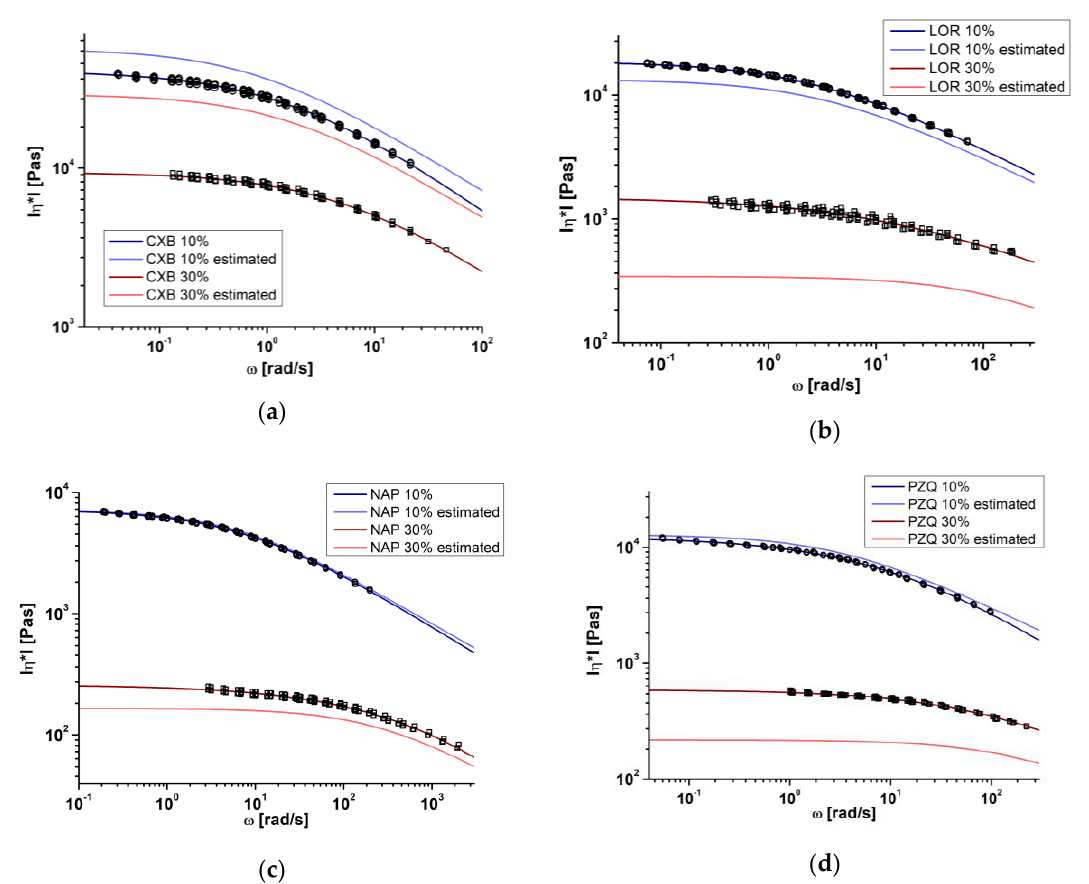
Figure 4. Comparison of estimated melt viscosity and small amplitude oscillatory shear (SAOS) experiments at 150 °C for celecoxib ( a ), loratadine ( b ), naproxen ( c ), and praziquantel ( d ) in copovidone.